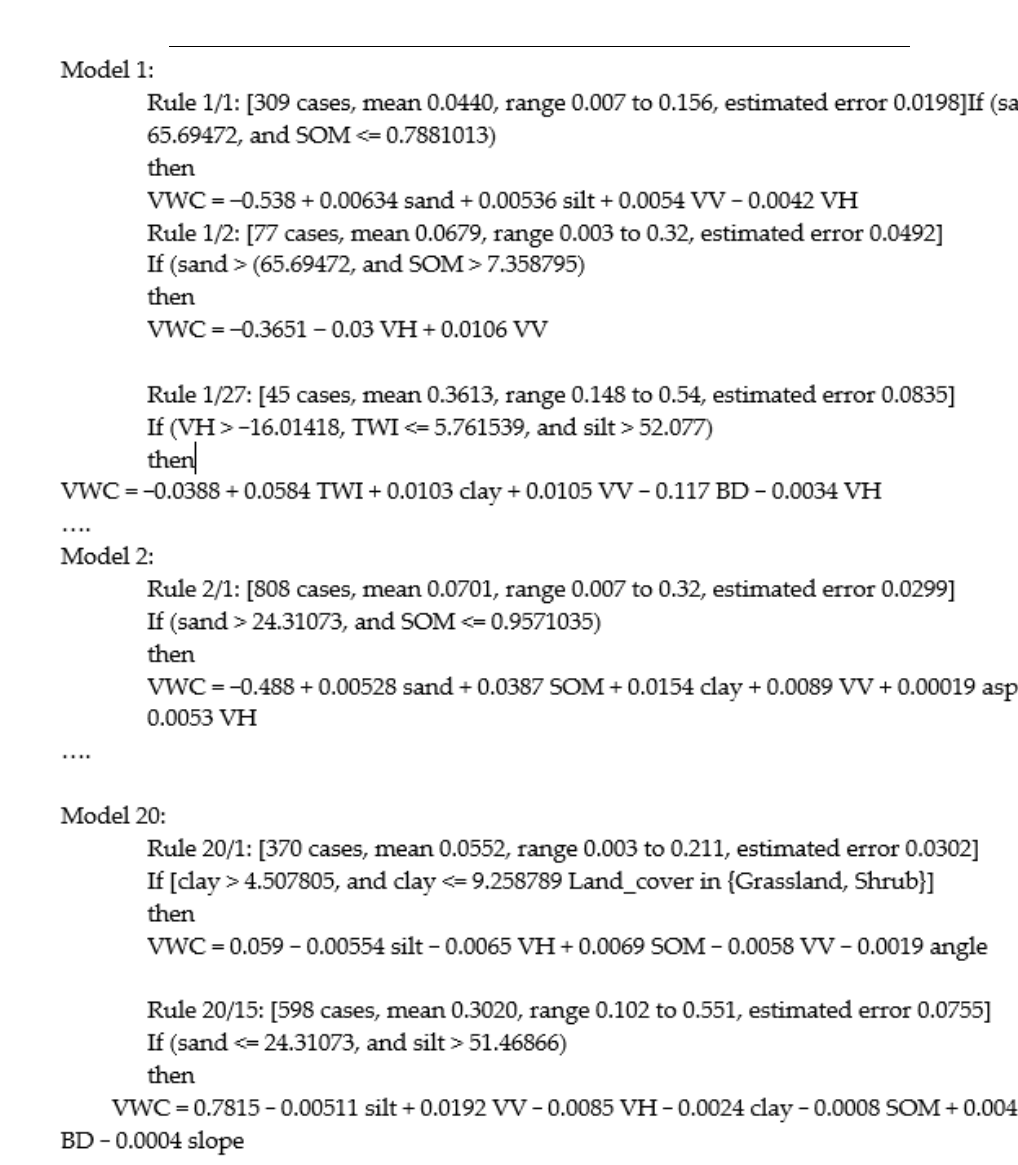
Figure A1. Summary of Cubist rules.